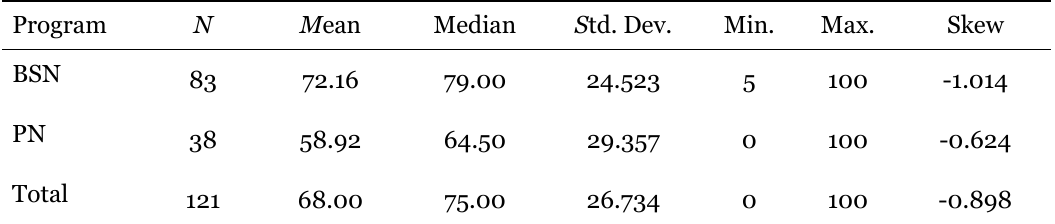
Self-Efficacy Scores – Program Comparison (Faculty–Student Combined) Program